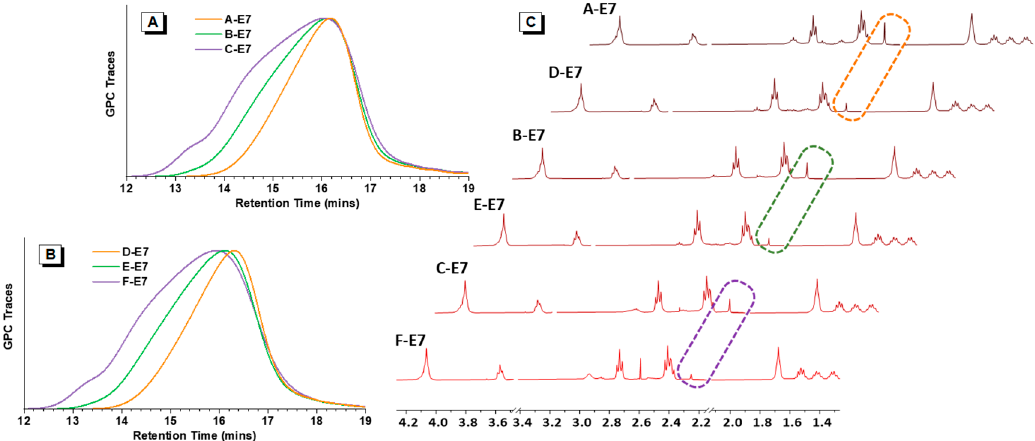
Figure 2. Polymer characterisation results. ( A ) GPC traces of A, B, C-E7 with different molecular weights. ( B ) GPC traces of D, E, F-E7 with different molecular weights. ( C ) 1 H NMR spectra of HPAEs, dashed boxes: ideal terminal groups signal peaks.